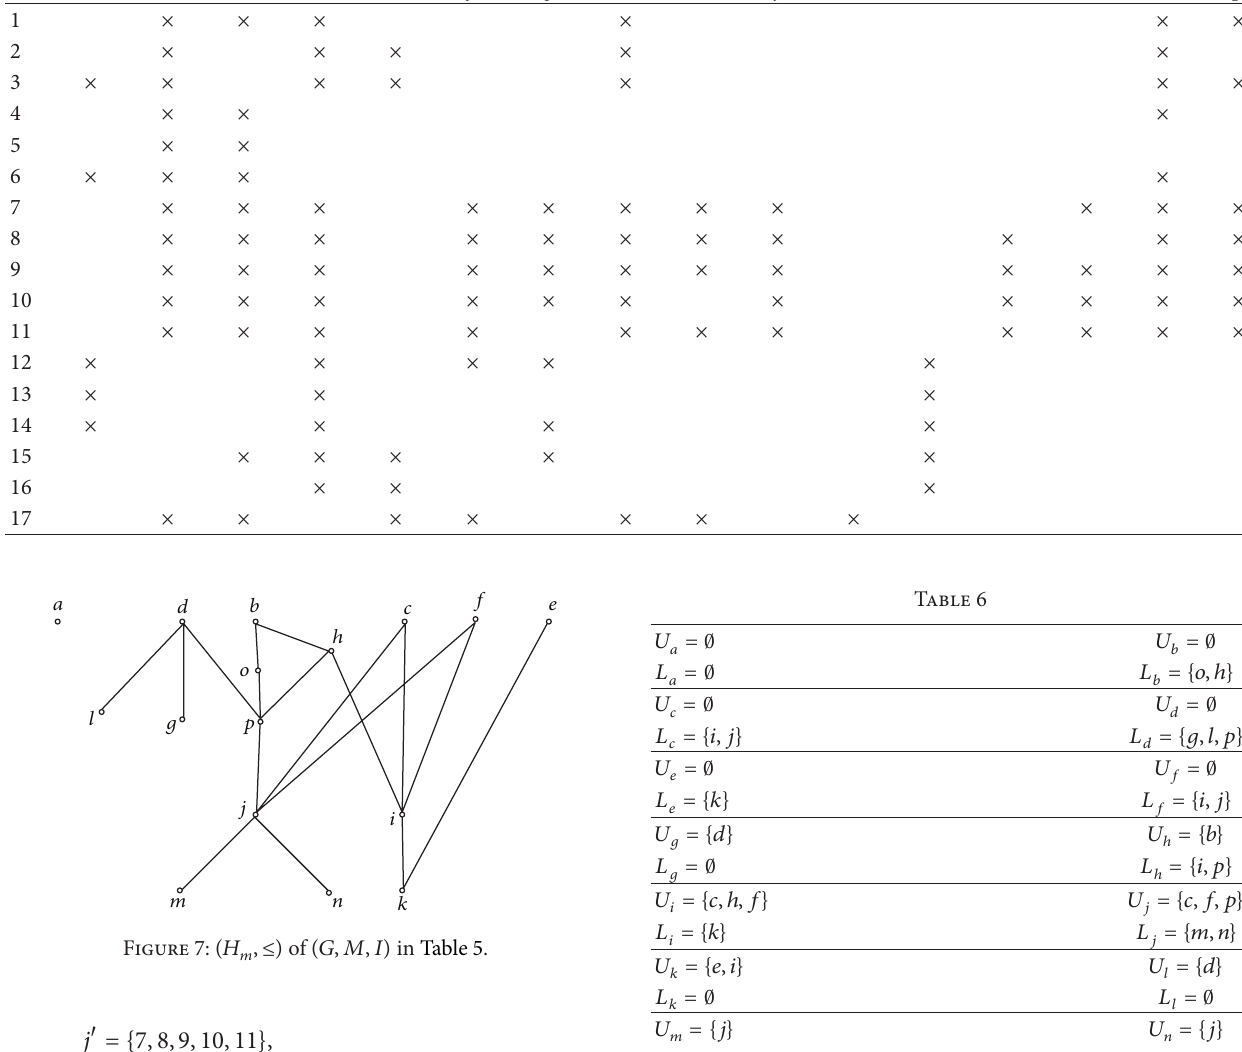
Table 5: Original formal context (𝐺,𝑀, 𝐼) from the bacterial data set.